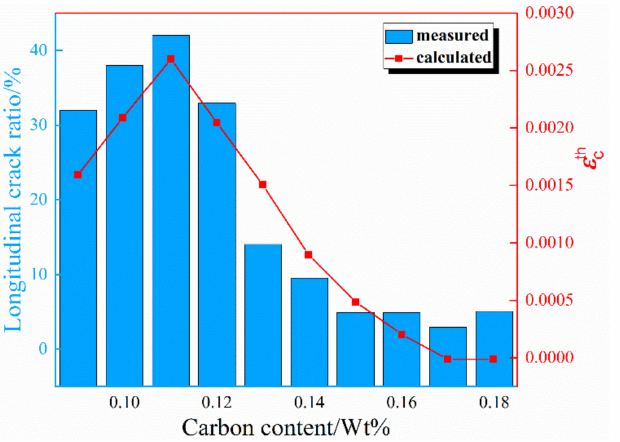
Figure 5. Comparison of measured data and calculated data by present